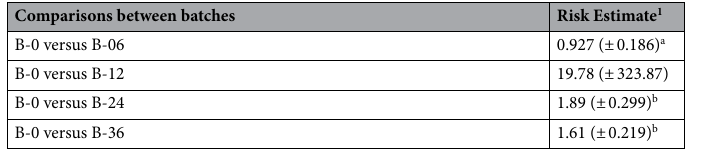
Table 4. Risk of TB infection per batch during the first year in contact with the TB positive herd. 1 Risk estimate coefficient of TB infection (± SE) between batches in farms 1, 2, 3 and 5, determined by a generalized mixed-effect model with post hoc Tukey comparisons between batches. a P = 0.0001, b P < 0.0001.